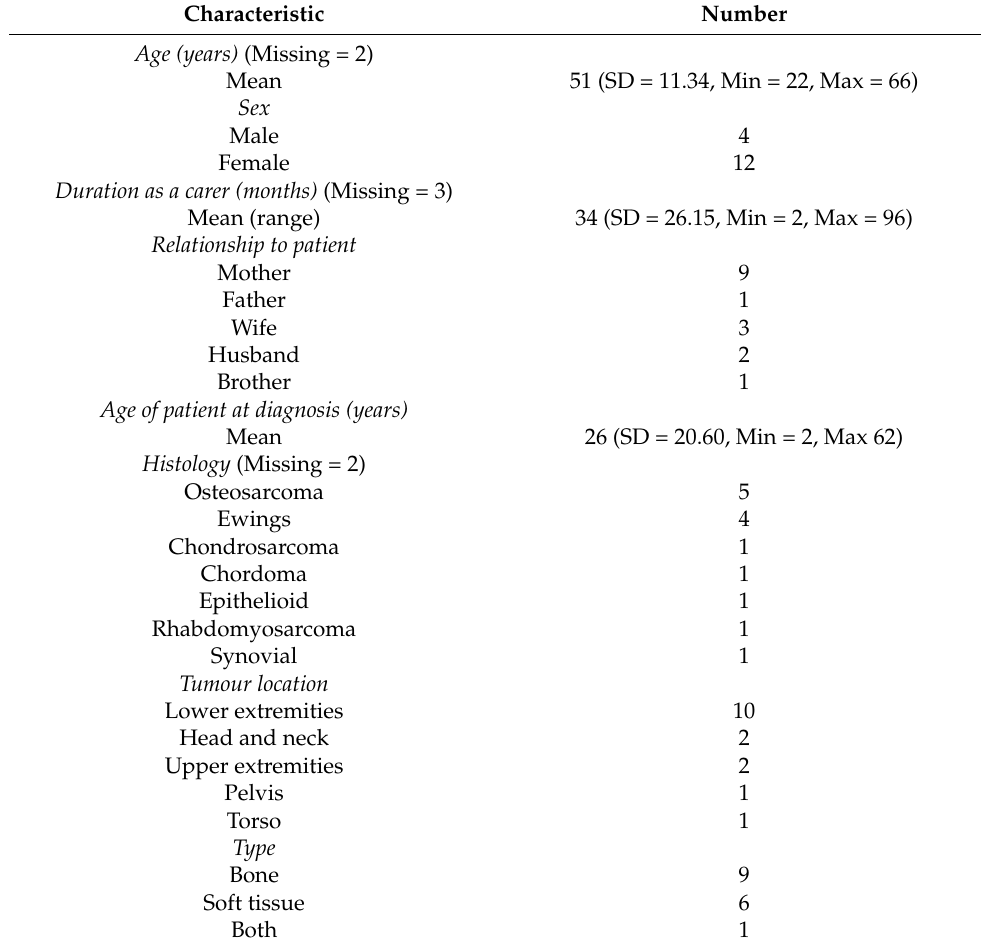
Table 2. Carer demographics ( n = 16). Characteristic